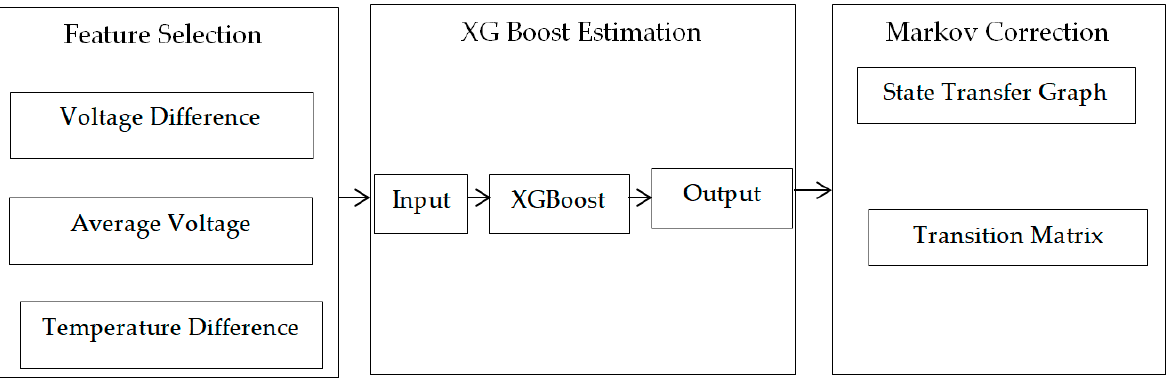
Figure 12. Flowchart of XGBoost and Markova Correction function in short MC-XGBoost model.